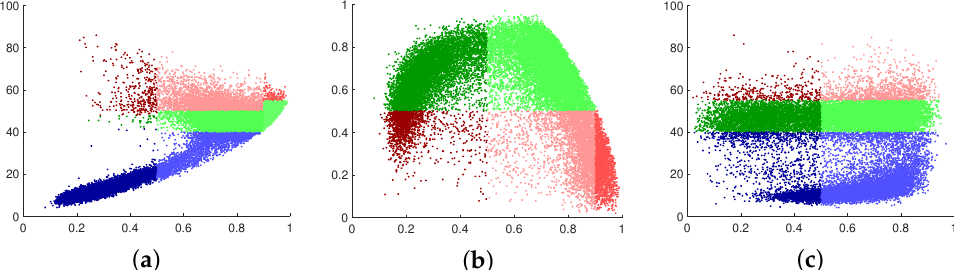
Figure 5. Classification hyperplanes and results of H / A / α of the RadarSat-2 PolSAR image. ( a ) Result of H / α hyperplane. ( b ) Result of H / A hyperplane. ( c ) Result of A / α